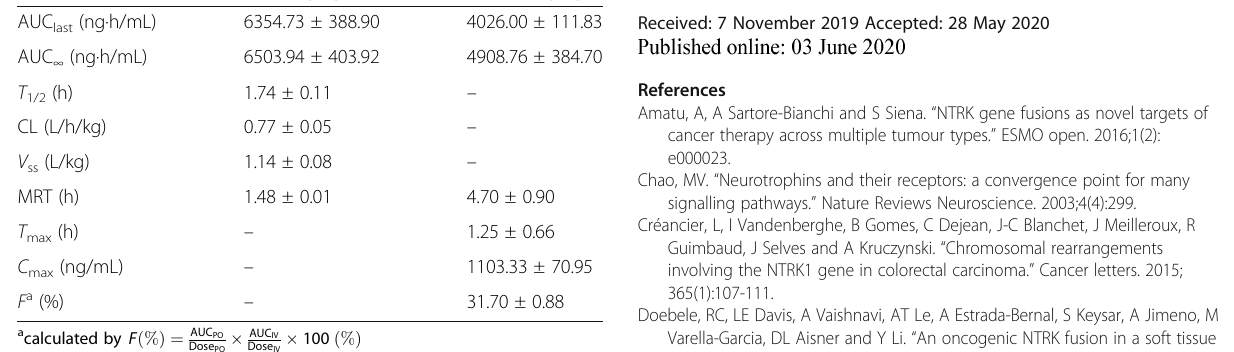
Table 4 Summary of pharmacokinetic parameters for larotrectinib in mice (mean ± SD, n = 3)